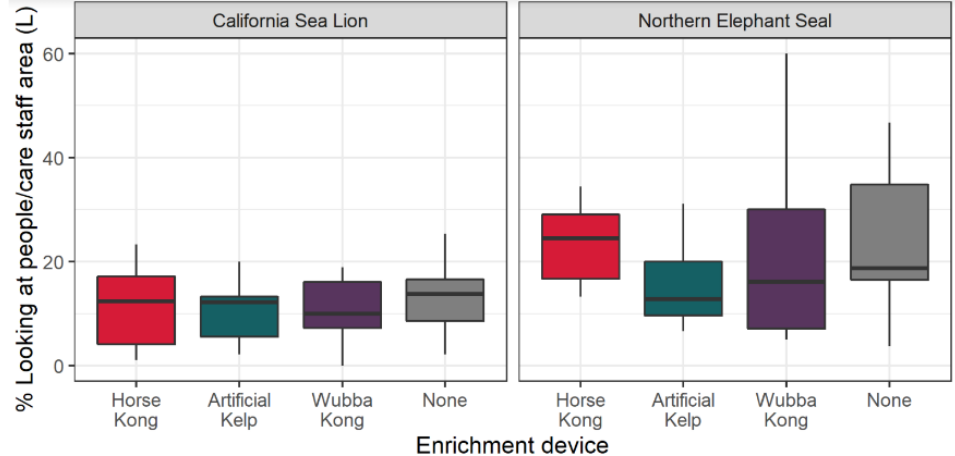
Figure 6. Boxplot describing medians, first quartile, third quartile (bars) and maxima and minima (whiskers) of percentages of time spent looking at people/care staff area during presentation sessions of environmental enrichment devices (Artificial Kelp, Horse Kong ™ and Wubba Kong ™ ), and with no EEDs present (“none”).